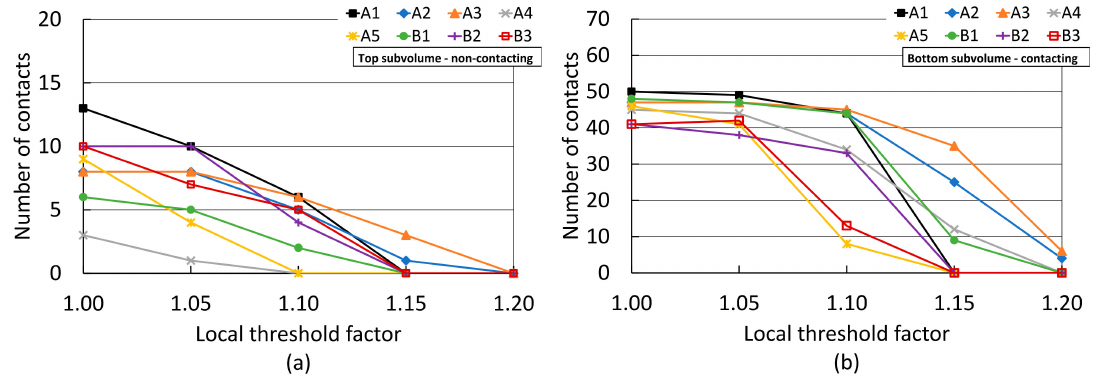
Figure 7. Number of detected contacts between pellet lattices after local refinement using different local threshold factors: ( a ) top subvolume with a prescribed interparticle separation; ( b ) bottom subvolume of full-contacting particles. See Table 1 for scan acquisition details. Data binarised using